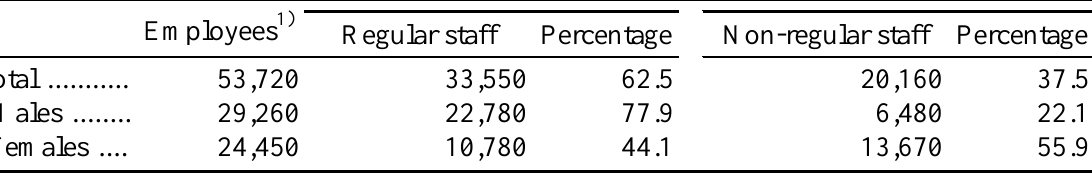
Employment by Employment Pattern